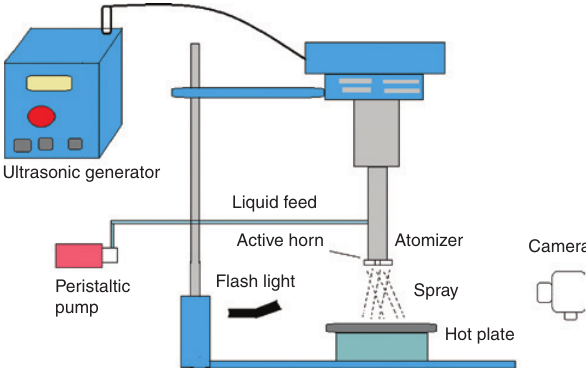
Figure 1: Schematic representation of the experimental setup.